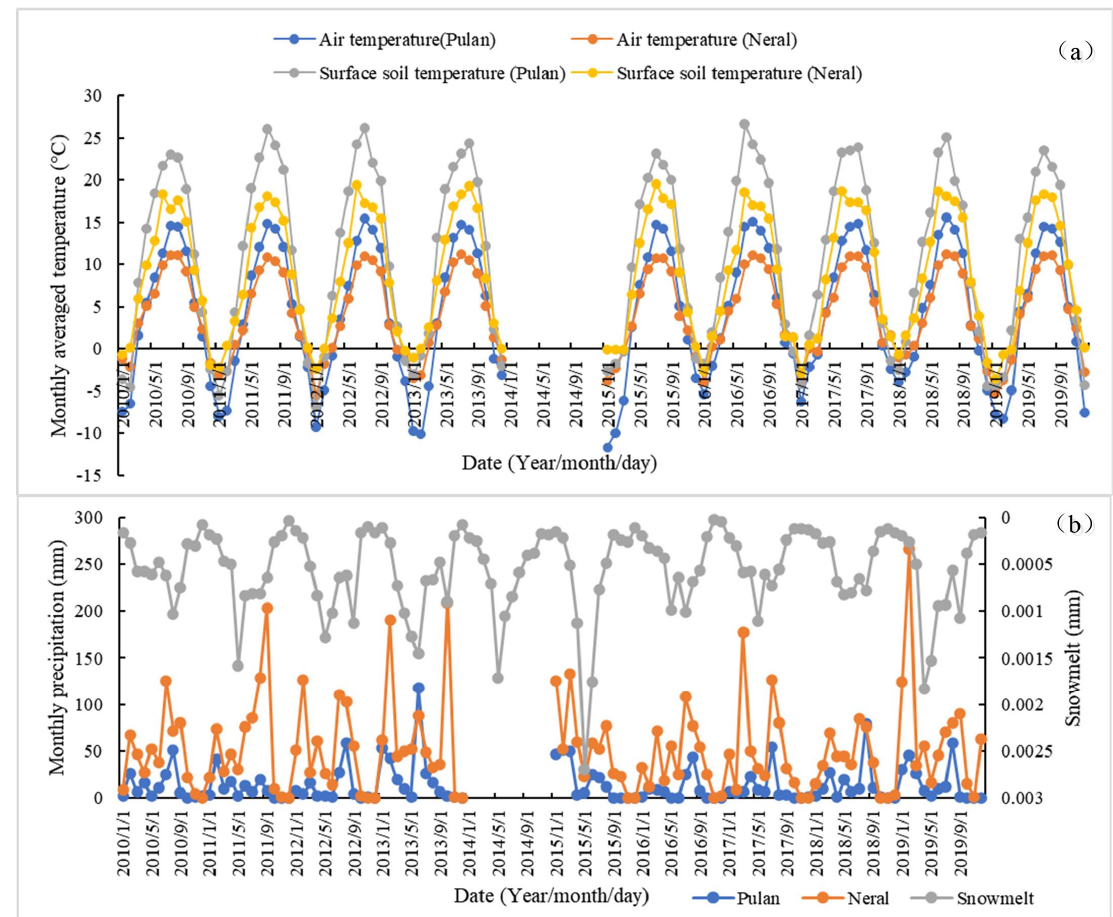
Figure 2. Monthly averaged ( a ) soil temperature and ( b ) precipitation records acquired from 2010 to 2019 (with 2014 records missing) at Pulan and Neral stations (Figure 1) (accessed from http://data.cma.cn/ in 6 November 2021) located within the study area. The snowmelt data in ( b ) were extracted from ERA-Interim reanalysis data (downloaded from https://cds.climate.copernicus.eu/ in 6 November 2021) for the same period.